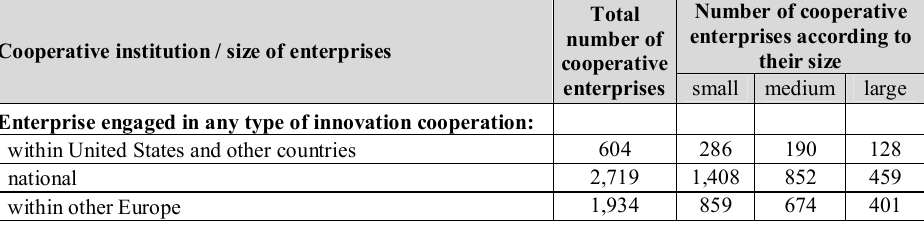
Number of cooperative Total enterprises according to number of their size cooperative enterprises small medium large